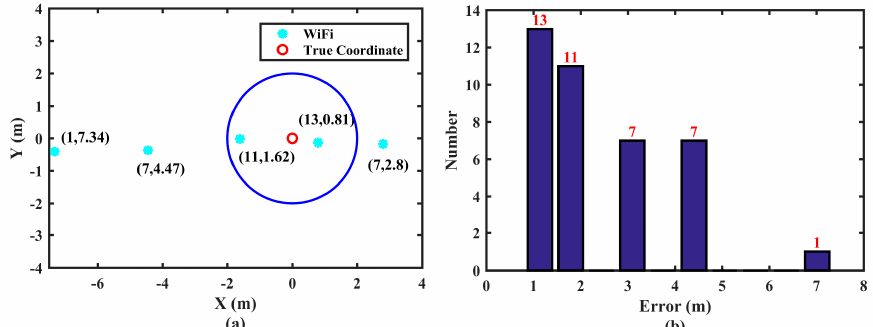
Figure 1. Experiment results in the static state. ( a ) The label next to the WiFi represents the received number and error, respectively, the blue circle represents a circle with a center at the true coordinate and a radius of 2 m; ( b ) The error histogram of WiFi.